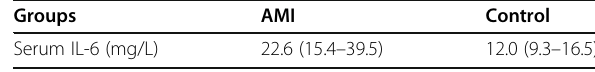
Table 1 Serum levels of IL6 in control and AMI groups Groups AMI Control